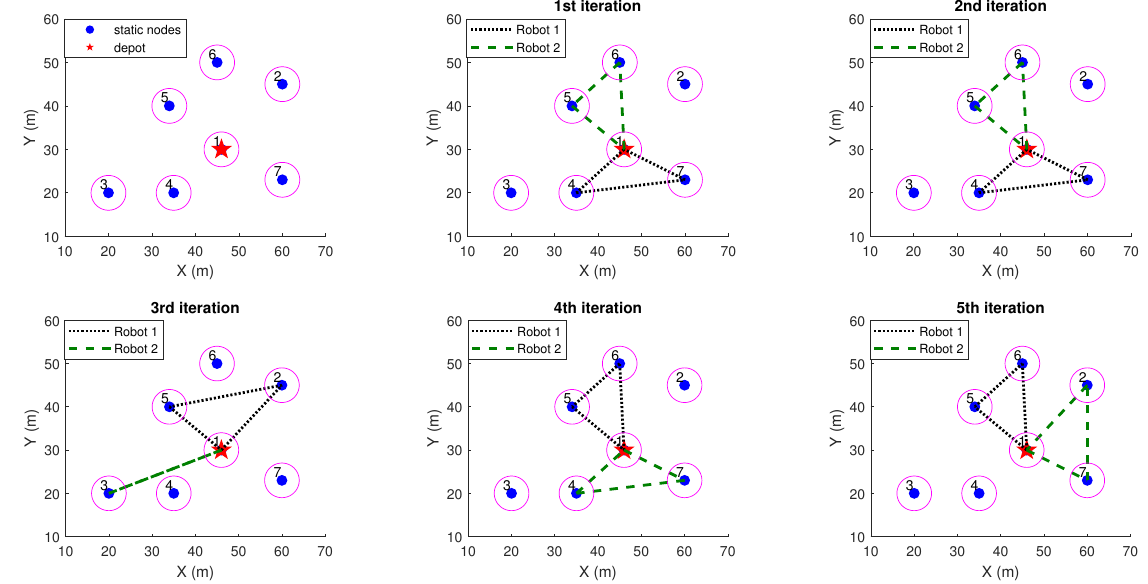
Figure 2. Mobile Element Scheduling Routes with 2 MoEls and 7